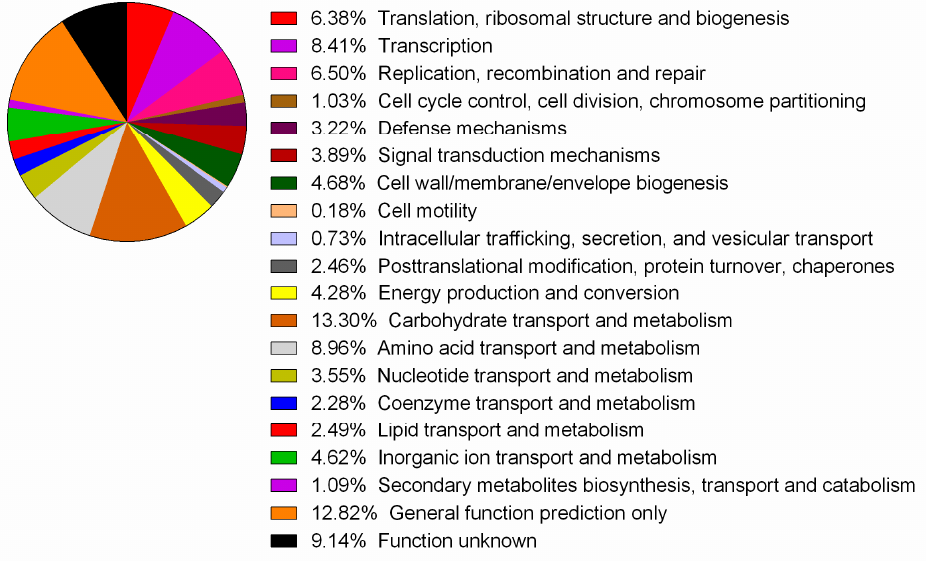
Figure 2. Relative abundance of genes associated with general clusters of orthologous groups(COG) functional categories in the UNQLpc10 strain.